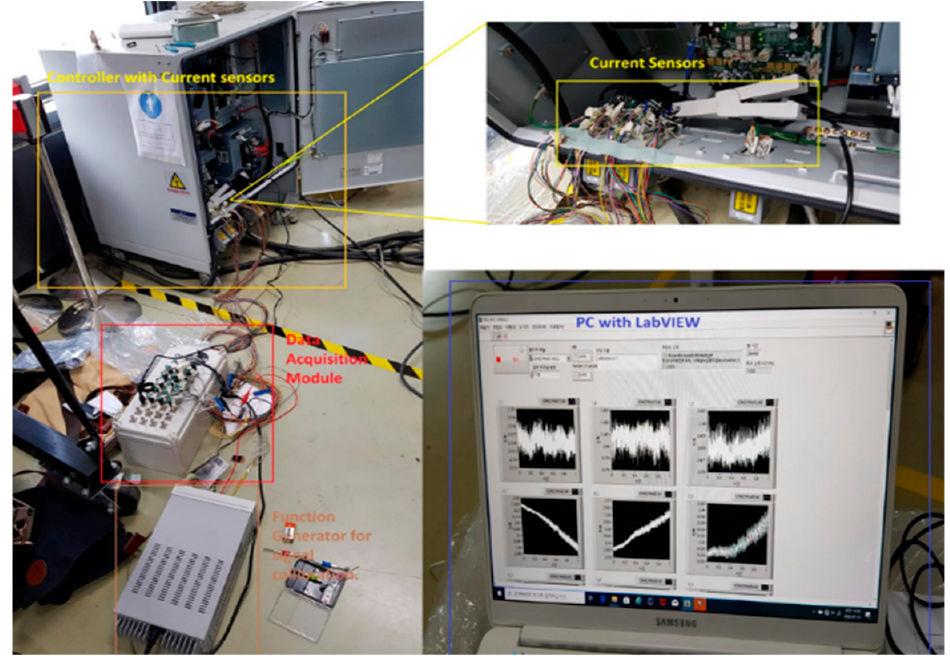
Figure 8. Details of the hardware used in the data collection.